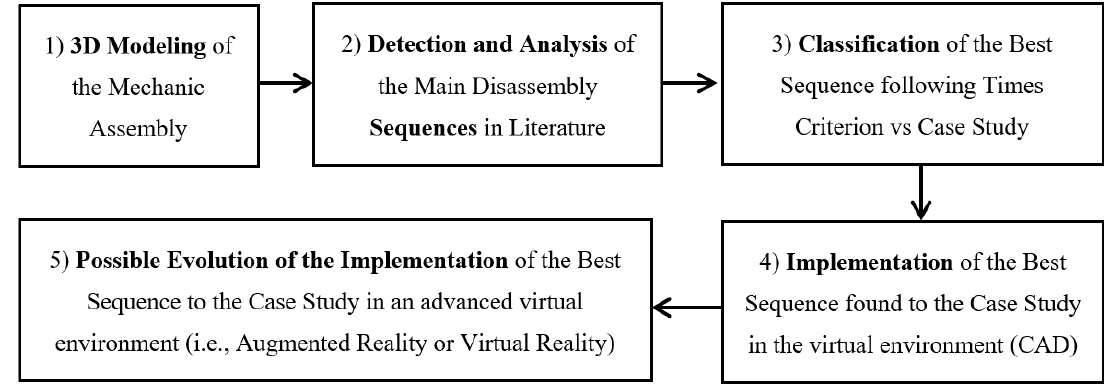
Figure 2. Block diagram of the methodology.